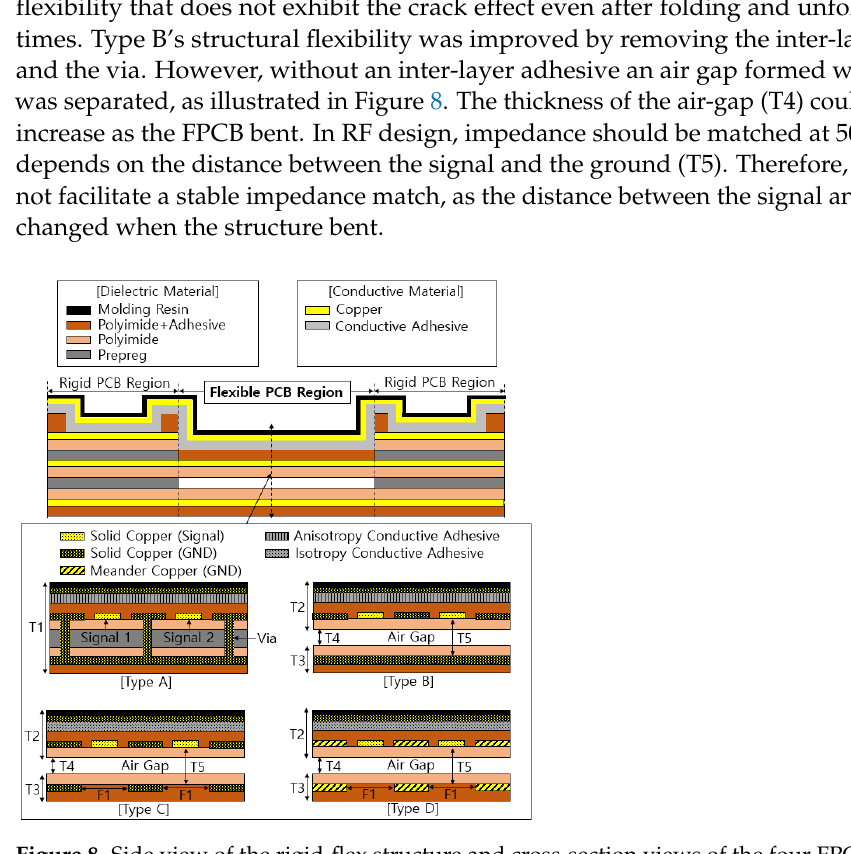
Figure 9. Comparison of major differences between FPCB structure